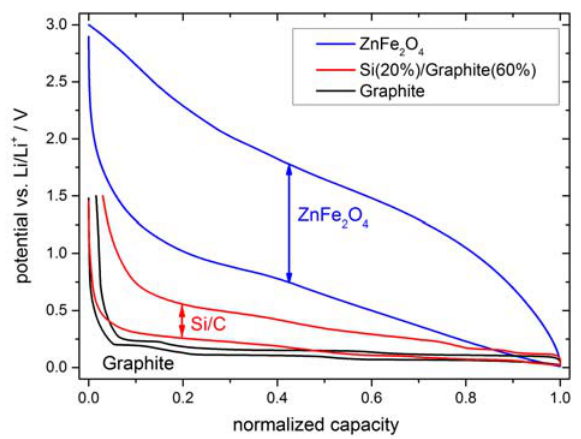
Figure 10. Potential vs. normalized capacity profiles of different anode materials: ZnFe te